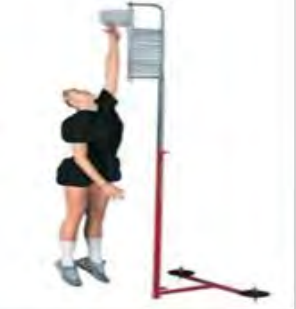
Fig.1. Schema of test 1 fulfillment